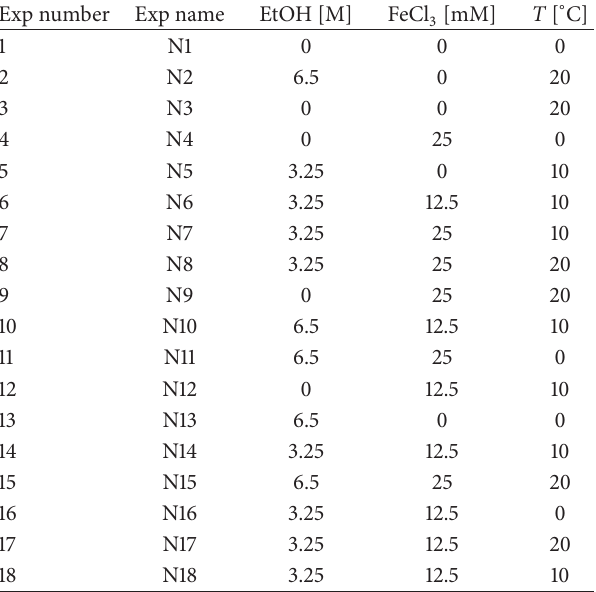
Table 2. To improve fit of model response transformation